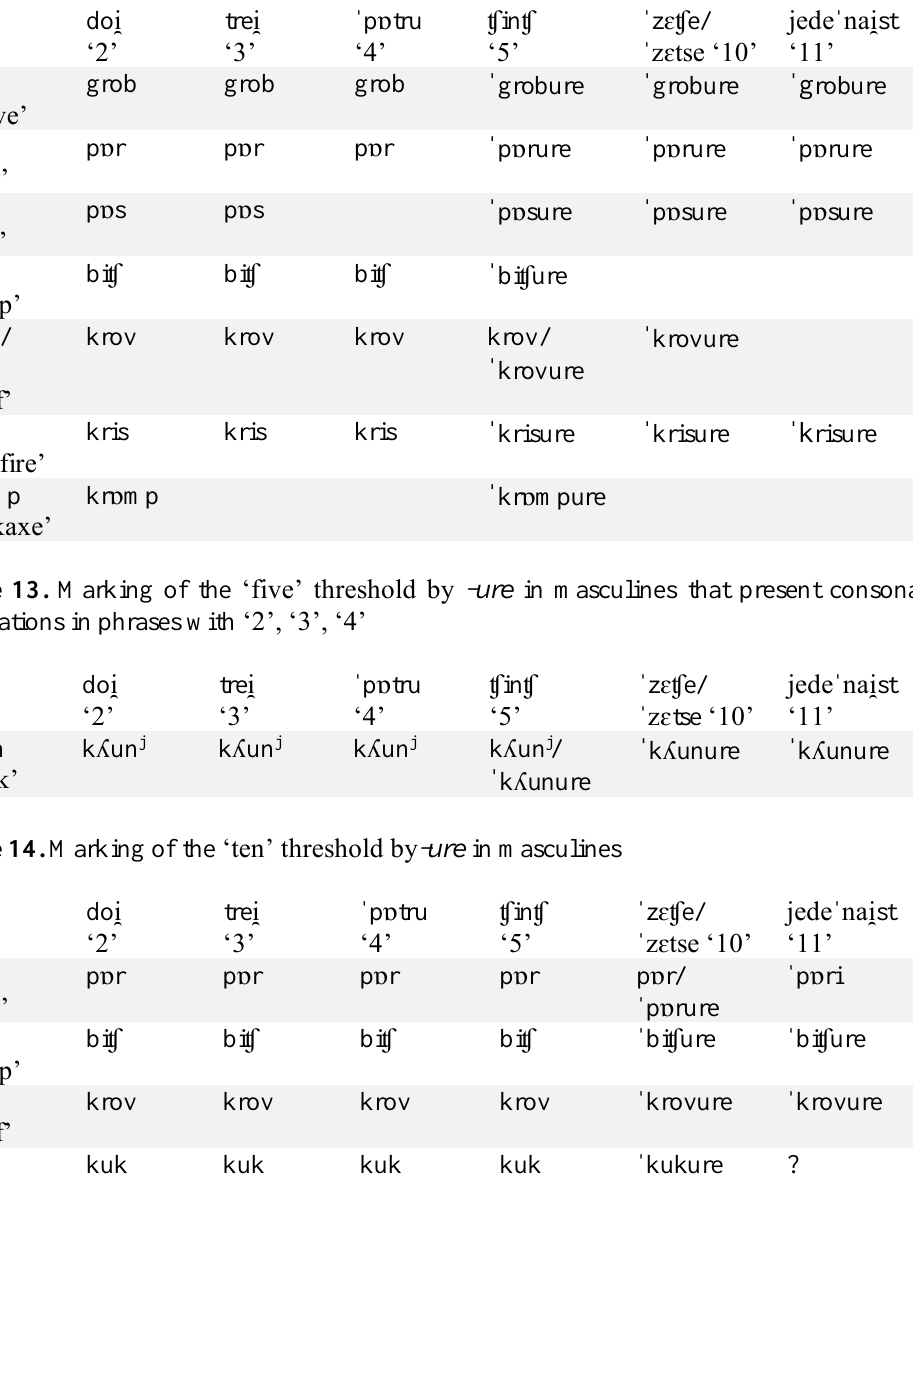
Table 12. Marking of the ‘five’ threshold by -ure in masculines that present neutralization of the plural opposition in phrases with ‘2’, ‘3’, ‘4’